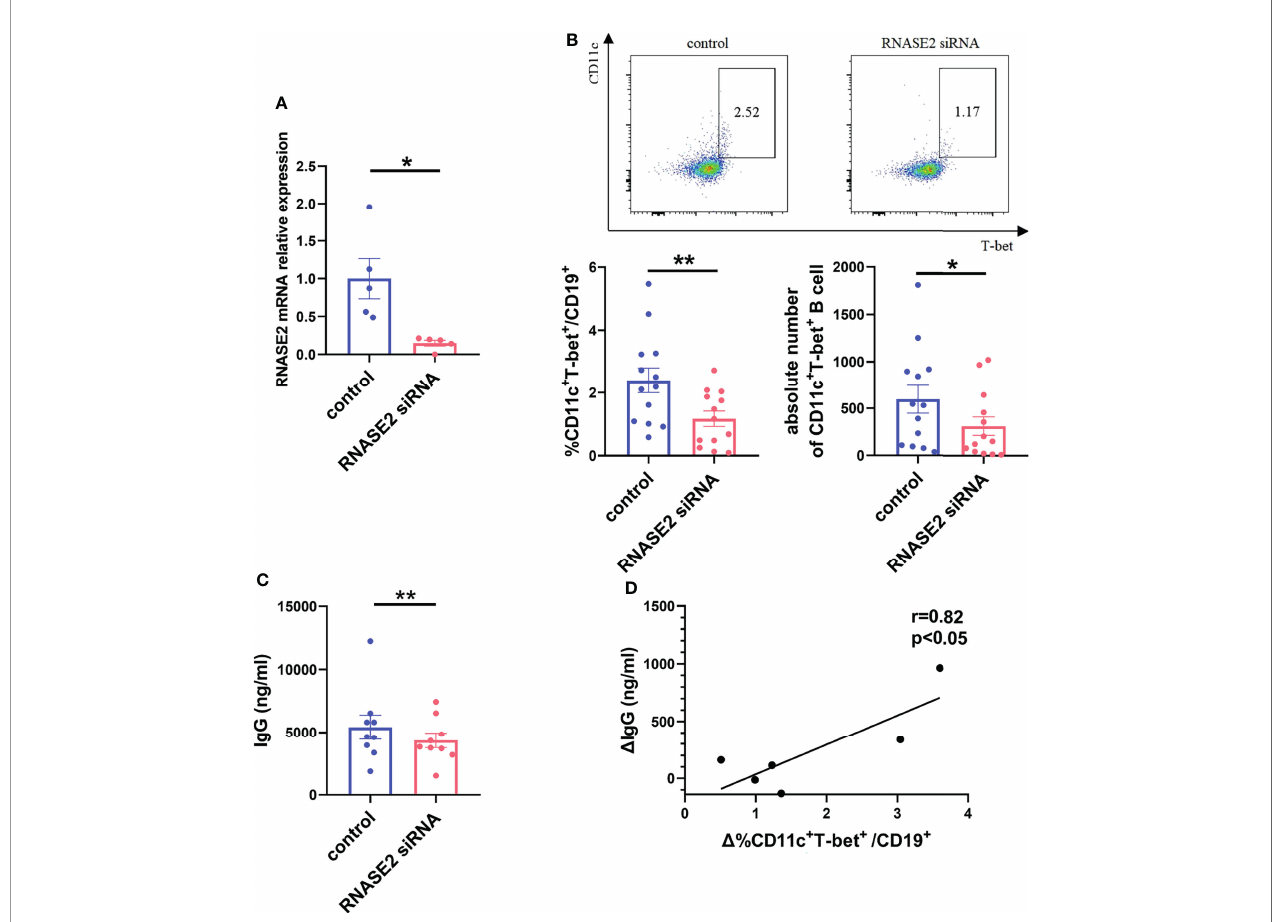
FIGURE 3 | RNASE2 participated in the regulation of ABCs. (A) Nearly 80% reduction in the gene expression 3 days after the treatment of RNASE2 siRNA in vitro (n=5). (B) Decreased percentage and absolute number of CD11c + T-bet + B cells after RNASE2 silencing by fl ow cytometry (n=13). (C) Down-regulated expression of total immunoglobulin (Ig) G in culture supernatants from RNASE2 silencing group (n=9), as determined by enzyme-linked immunosorbent assay (ELISA). (D) The difference of IgG level between silence group and control group was positively correlated to the alteration of ABCs proportion (n= 6). Data are presented as mean ± SEM, *p < 0.05, **p <